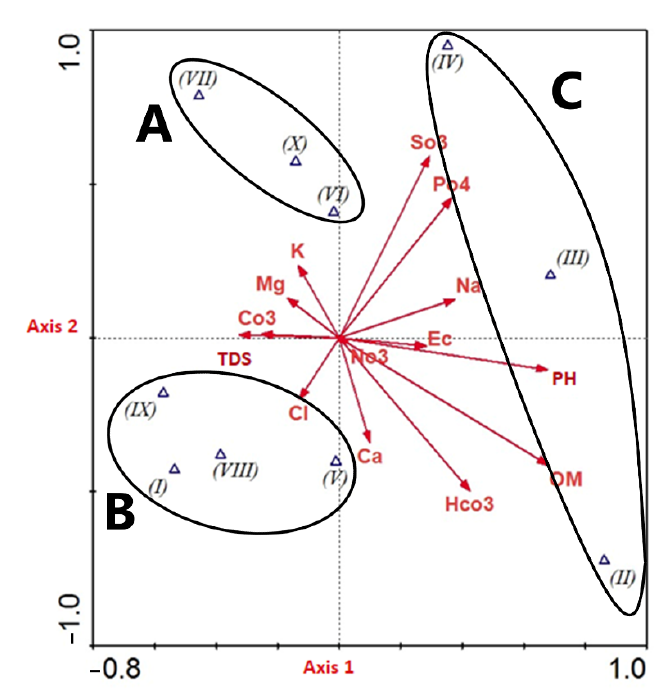
Figure 6 . CCA Biplot ordination of the environmental variables (arrows) and the TWINSPAN veg-